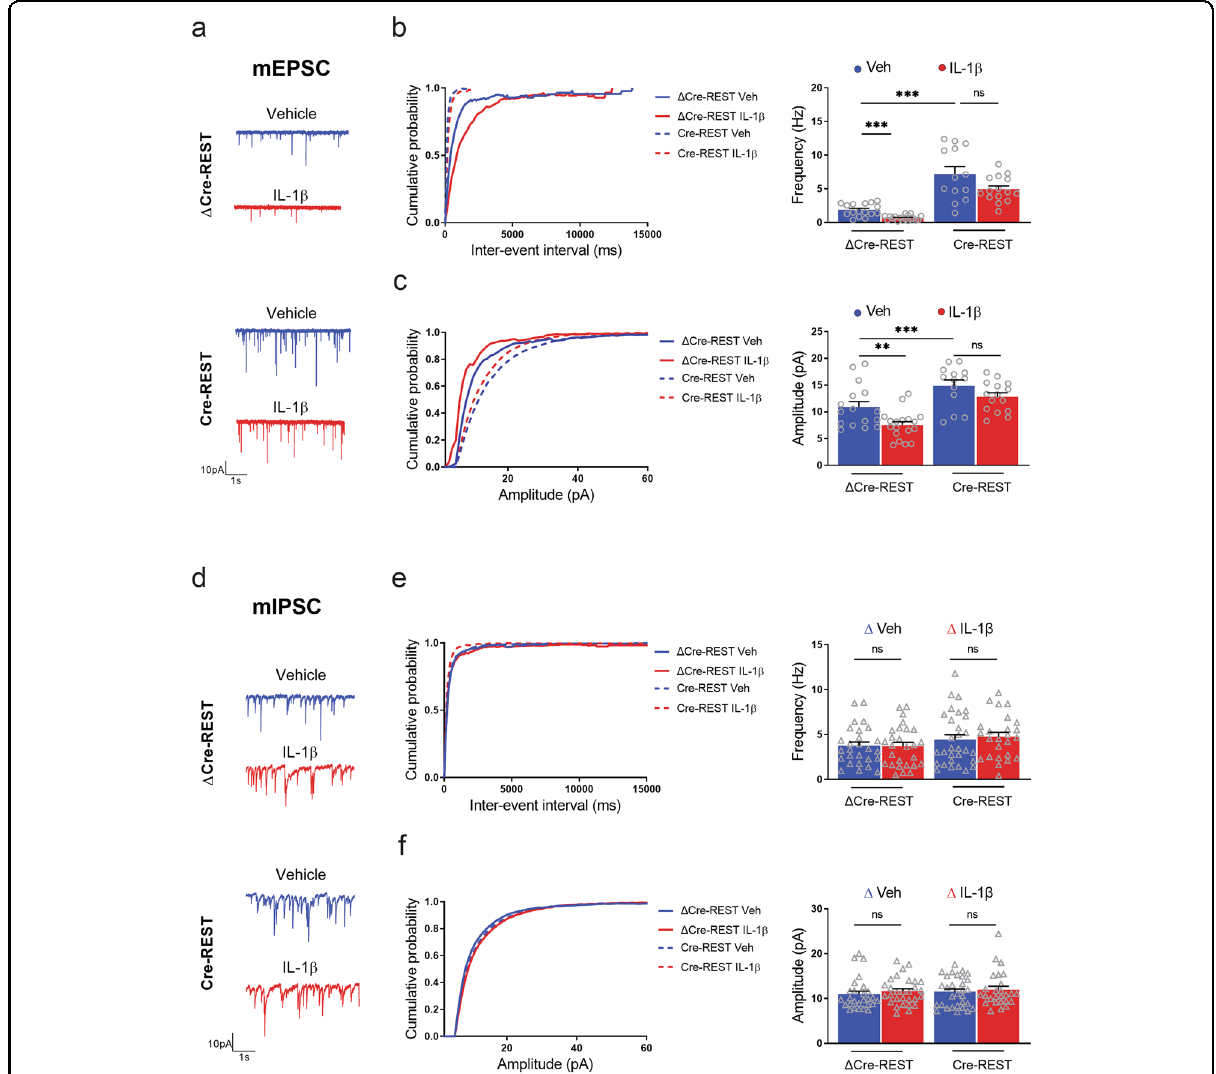
Fig. 5 REST deletion occludes the effects of IL-1 β treatment on excitatory transmission. a – c Representative traces ( a ), cumulative distribution of inter-event intervals (left) and mean frequency (right) ( b ), and cumulative distribution (left) and mean amplitude (right) ( c ) of mEPSCs in Δ Cre-REST and Cre-REST transduced cortical neurons treated with either vehicle (blue traces) or IL-1 β (red traces) for 20 min at 7 DIV. Recordings were performed at 14 DIV. d – f Representative traces ( d ), cumulative distribution of inter-event intervals and mean frequency ( e ), and cumulative distribution and mean amplitudes ( f ) of mIPSCs recorded under the same experimental conditions described above. Graphs show mean ± sem of at least three independent preparations with superimposed individual points. Excitatory synapses: n = 16, 18, 13, and 15; inhibitory synapses: n = 27, 29, 30, and 26 for Δ CRE-REST Veh, Δ CRE-REST IL-1 β , CRE-REST Veh, and CRE-REST IL-1 β , respectively. ** p < 0.01, *** p < 0.001, ns: p > 0.05; two-way ANOVA/ Bonferroni ’ s